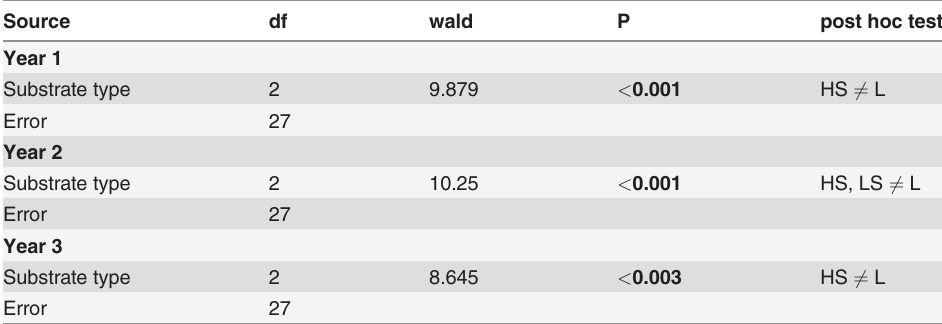
Table 3. Species composition.